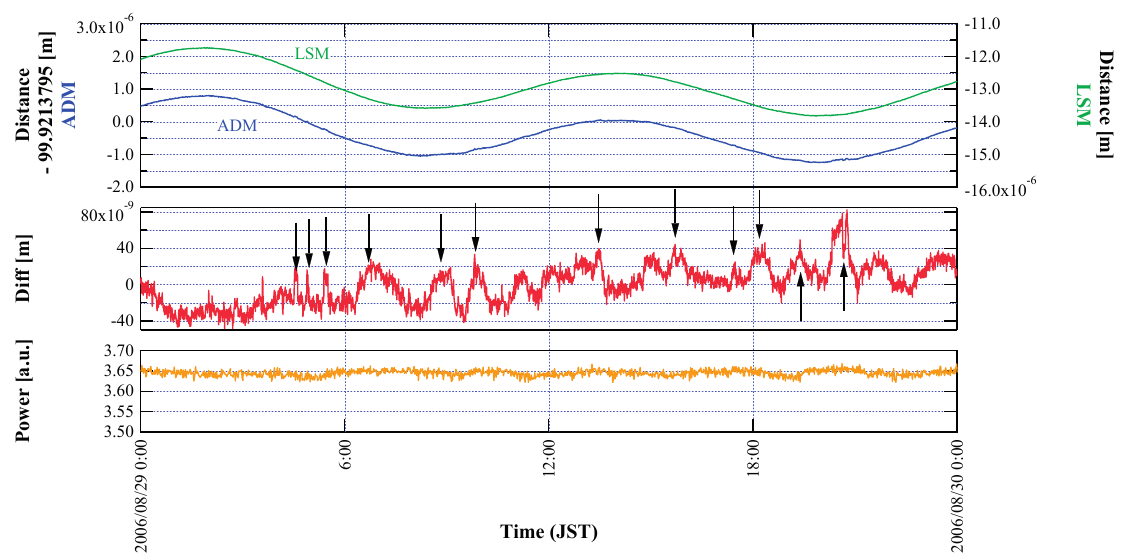
Figure 7. Glitches observed in the ADM output. Absolute distance measured with the ADM (blue), the LSM data (green) and their difference